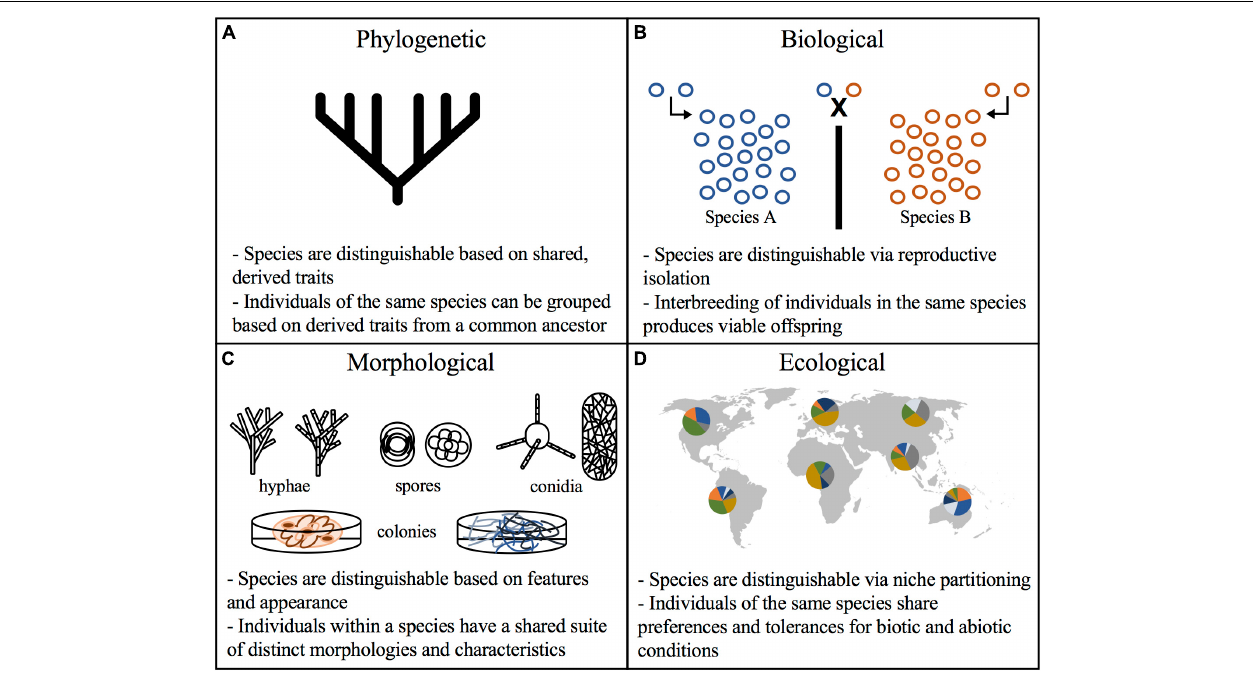
FIGURE 1 | Species concepts criteria for fungal delimitation. Predominant species concepts and the features used to distinguish species. (A) Phylogenetic species concept relies on parsimony in reconstructions of taxa relatedness and groups organisms by shared traits; (B) biological species concept draws boundaries based on reproductive isolation wherein organisms incapable of producing viable offspring are considered separate species; (C) morphological species concept distinguishes species using macro and micro morphology, including colony appearance, pigmentation, conidia, mycelia, and spores; (D) ecological species concept evaluates biogeographical ranges and potential niches to delimit taxonomic